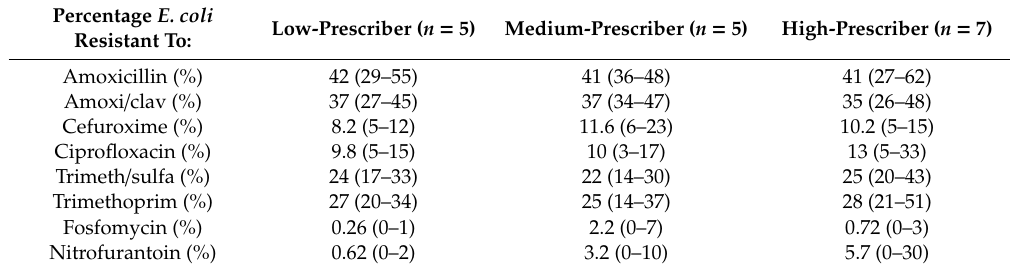
Table 3. Percentages of antibiotic resistant E. coli from urine cultures split per prescriber group. Percentage E. coli Resistant